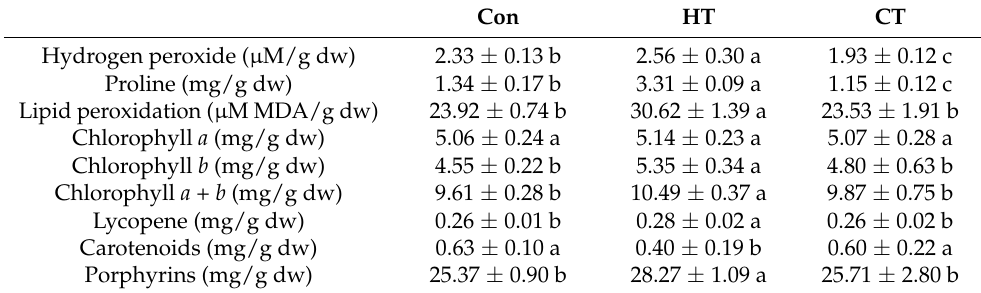
Table 2. Effects of hot- and cold-water stress on parameters of oxidative stress and pigments in